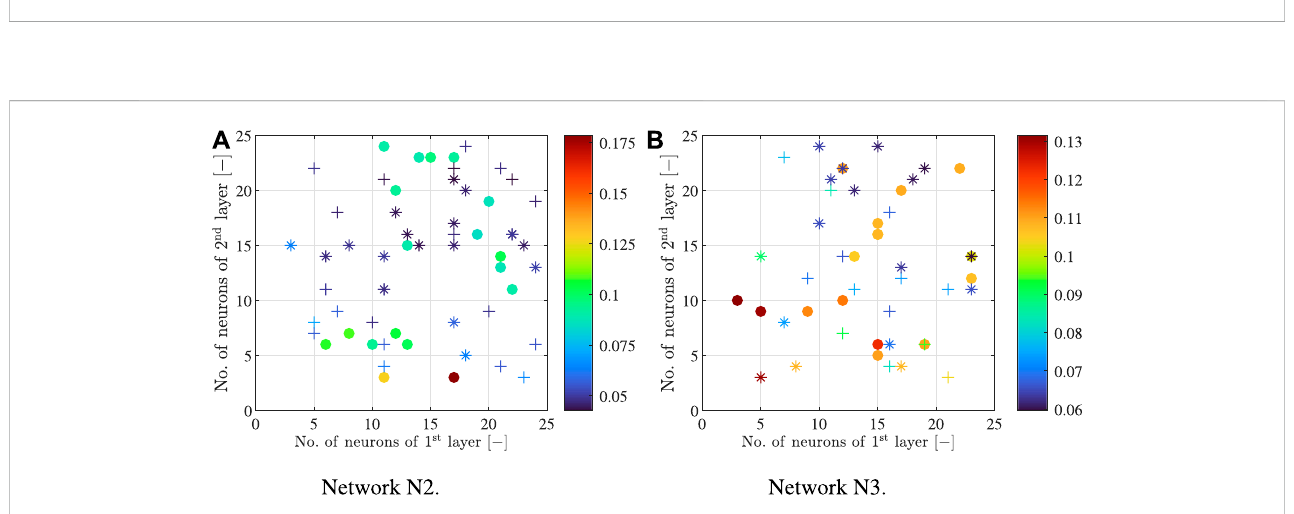
FIGURE 5 Numerical case study: performance of the networks with two hidden layers in function of the number of neurons in each layer and the transfer function (cid:129) : ReLU transfer function; +: Sigmoid logistic transfer function; p : hyperbolic tangent transfer function. type; (A) Network N2 and (B) Network N3.